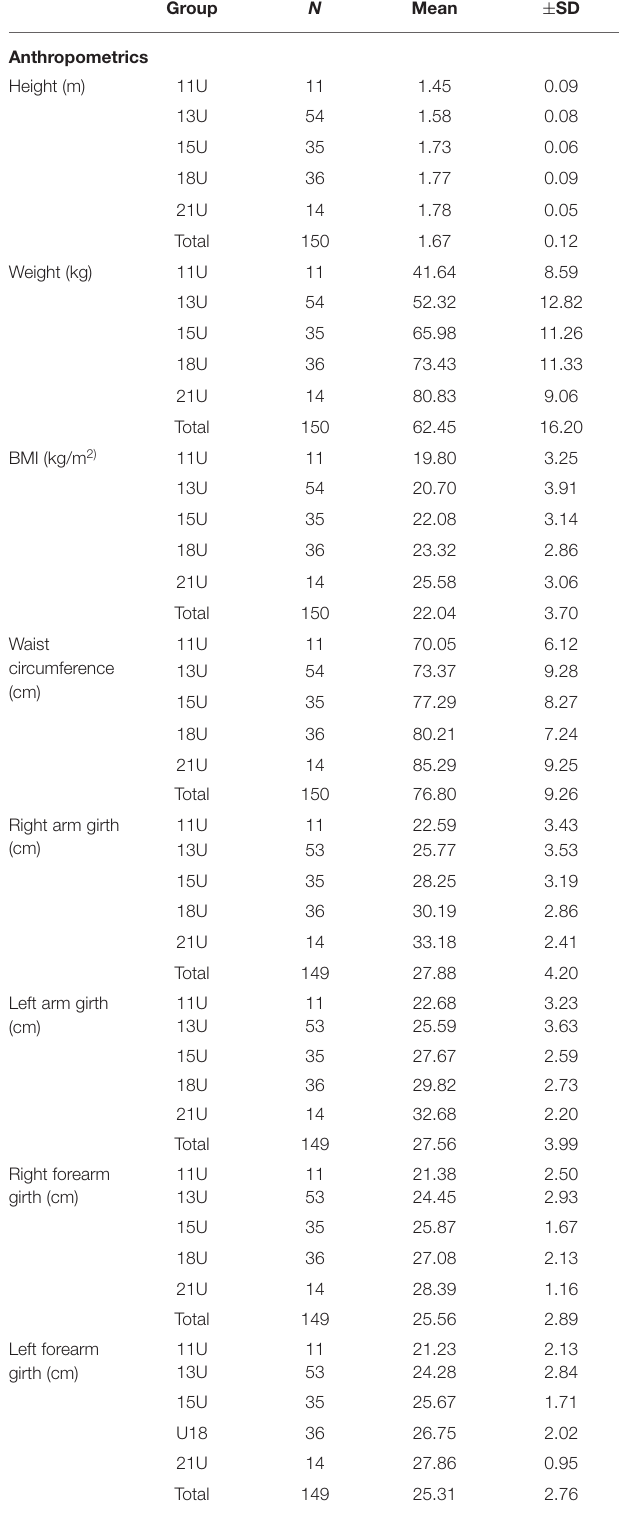
TABLE 3 | Results of anthropometric, athletic ability, and perceptual-cognitive skill assessments of male athletes. Group